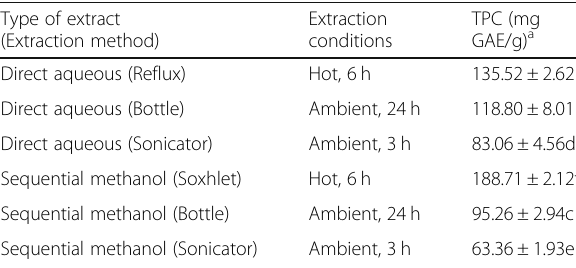
Table 2 Total phenolic content (TPC) of direct aqueous and sequential methanol extracts